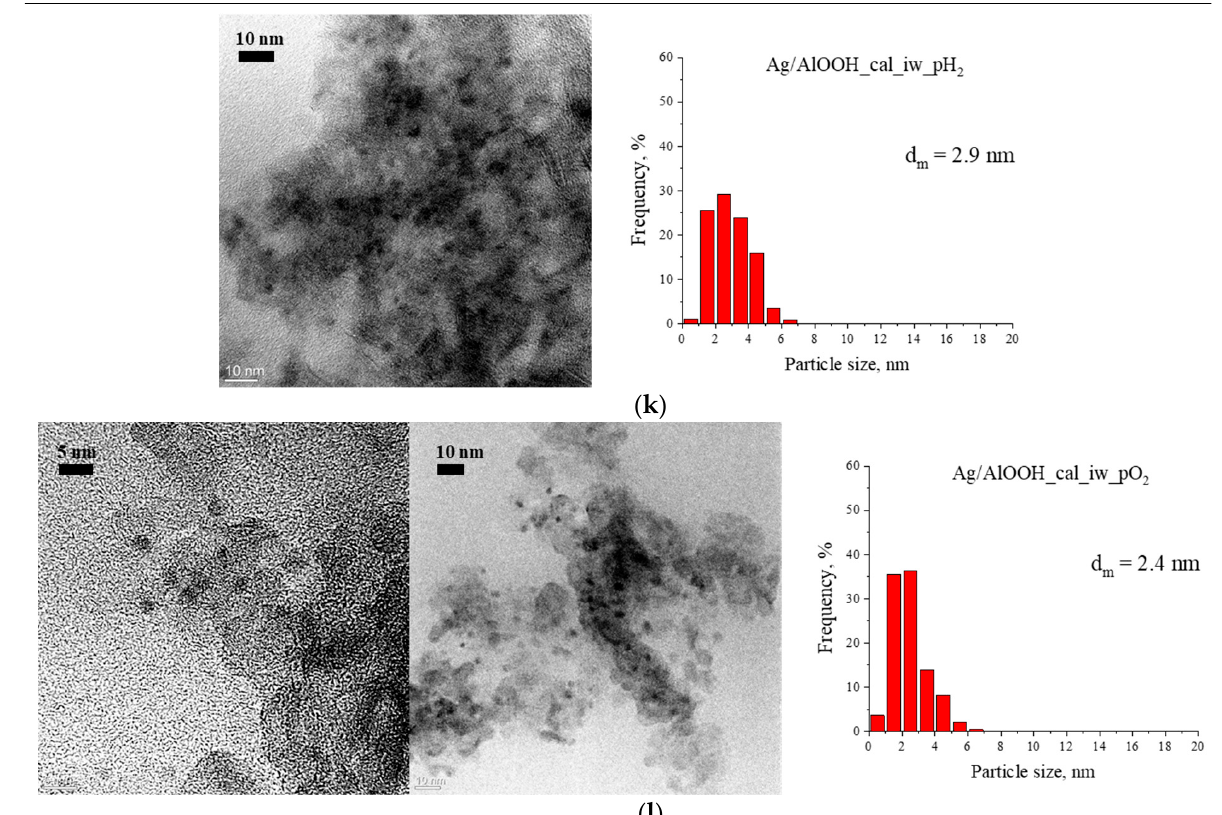
Figure 1. TEM micrographs and Ag particle size distribution of the studied catalysts: ( a ) Ag/ γ -Al 2 O 3 _dp_pH 2 ; ( b ) Ag/ γ - Al 2 O 3 _dp_pO 2 ; ( c ) Ag/ γ -Al 2 O 3 _iw_pH 2 ; ( d ) Ag/ γ -Al 2 O 3 _iw_pO 2 ; ( e ) Ag/AlOOH_dp_pH 2 ; ( f ) Ag/AlOOH_dp_pO 2 ; ( g ) Ag/AlOOH_iw_pH 2 ; ( h ) Ag/AlOOH_iw_pO 2 ; ( i ) Ag/AlOOH_cal_dp_pH 2 ; ( j ) Ag/AlOOH_cal_dp_pO 2